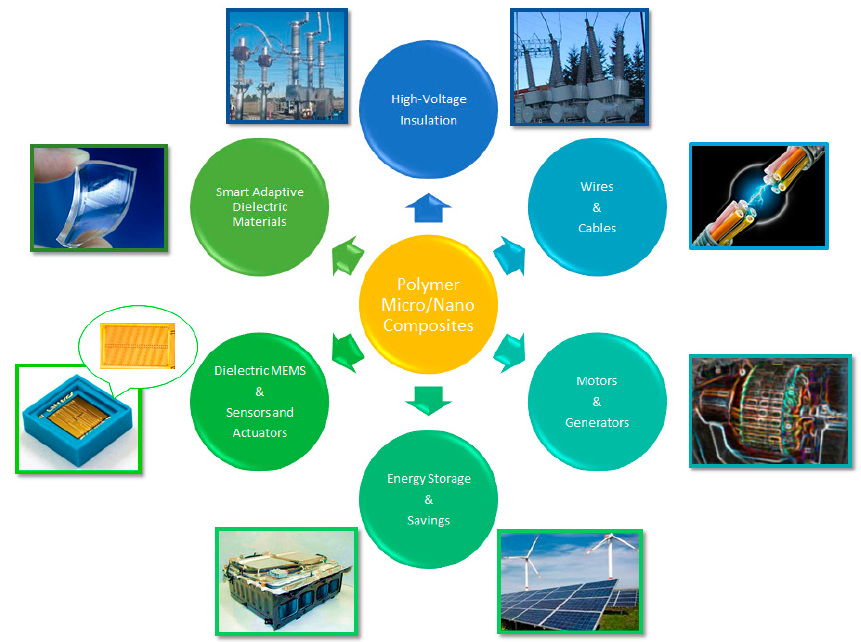
Figure 1. The next generation of high-voltage applications employing polymer based nanocomposites.